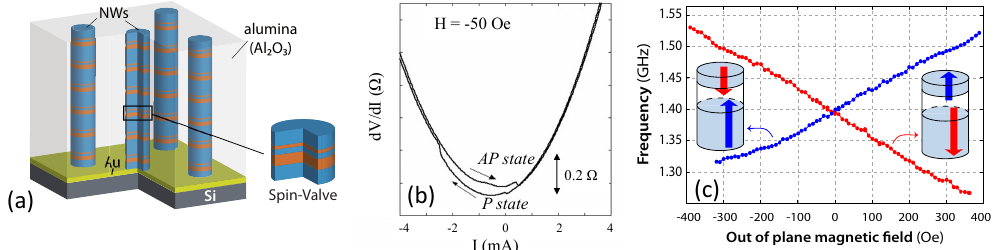
Figure 10. ( a ) CPP-GMR versus magnetic field applied in the plane of the crossed NW networks at T = 15 K and T = 300 K for ( a ) Co/Cu, ( b ) CoNi/Cu and ( c ) Py/Cu multilayered nanowires (adapted from [64,65,67]). Figure adapted from ref. [65] with permission of the author.